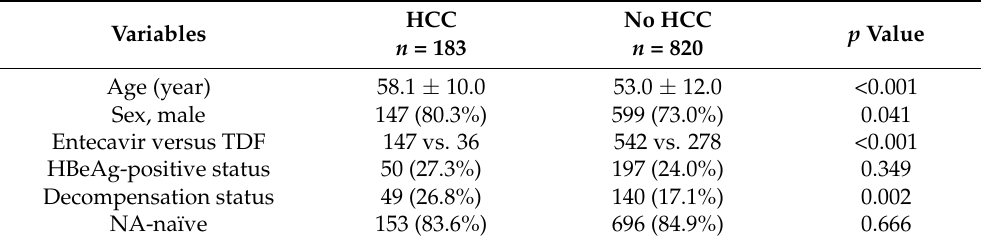
Table 1. Baseline clinical characteristics of patients with HCC or without HCC